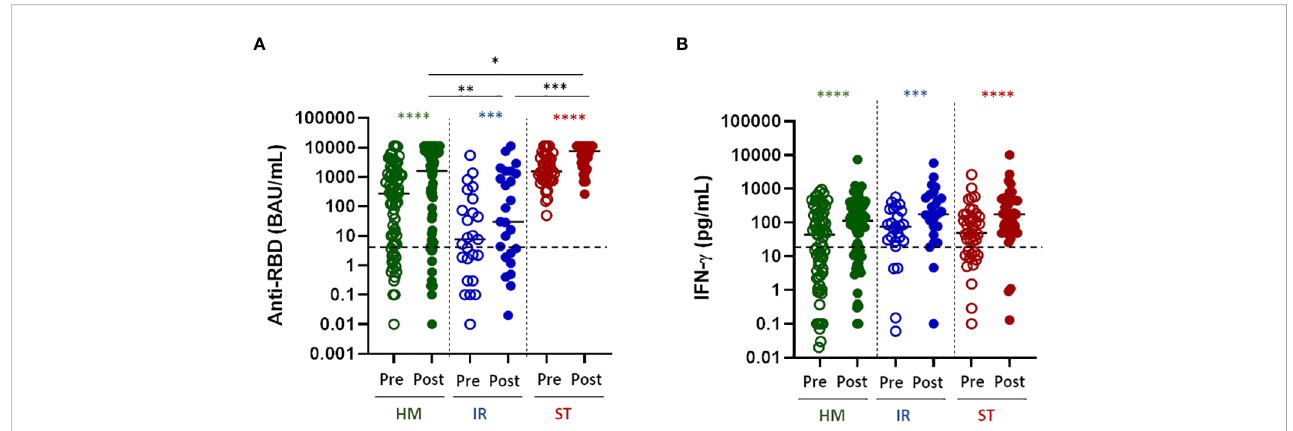
FIGURE 1 Humoral and T-cell response to the fourth dose of mRNA vaccine in fragile patients. (A) SARS-CoV-2 speci fi c anti-RBD antibodies (Abs) were measured in sera samples of HM (green dots), IR (blue dots) and ST (red dots) patients before (pre) and after (post) the fourth dose of mRNA vaccine. The level of anti-RBD Abs was expressed as BAU/mL. HM-pre median= 274.8 BAU/mL (IQR 5.2 – 1357 BAU/mL); HM-post median=1624.0 BAU/mL (IQR 10.7-7269). IR-pre median= 7.6 BAU/mL (IQR 1.0-128.3 BAU/mL); IR-post median= 30.5 (IQR 2.2-1458 BAU/mL). ST-pre median= 1546.0 BAU/ml (810.4-4389 BAU/ mL); ST-post median= 7632 (3023-11360 BAU/ml). The dashed line indicates the cut-off value (7.1 BAU/mL). Differences between anti-RBD Abs titre before and after the fourth dose within the same group were evaluated by Wilcoxon paired test, while differences across groups were evaluated by